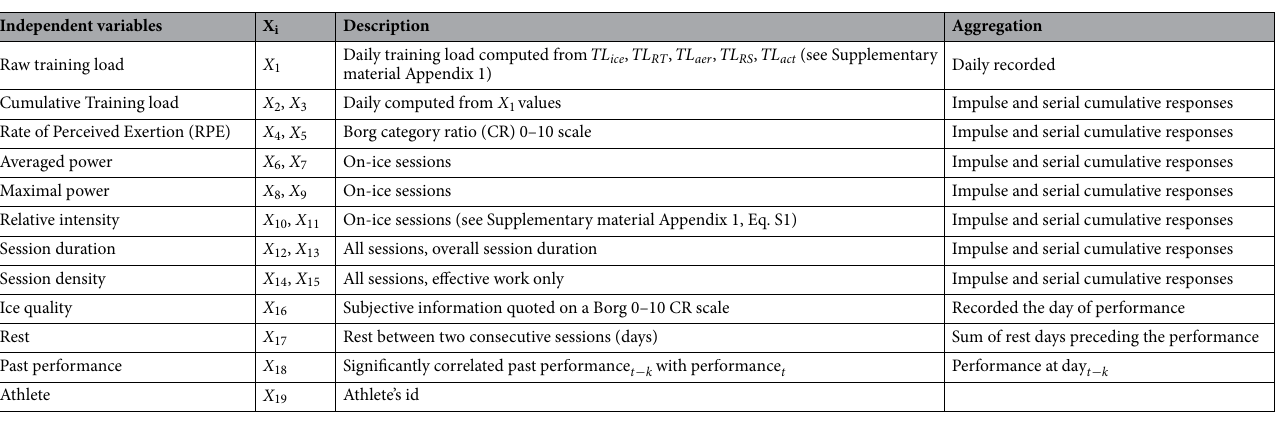
Table 1. Summary of independent variables. The two aggregation methods (impulse ans serial cumulative responses) are defined in Eqs. (1) and